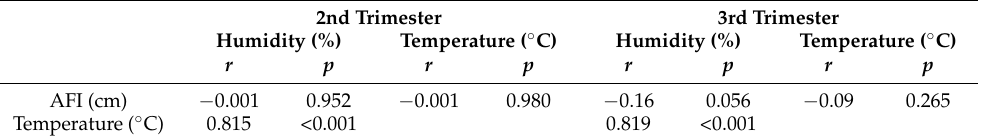
Table 3. Correlation among AFI, temperature, and humidity in the 2nd and 3rd trimester of pregnancy.